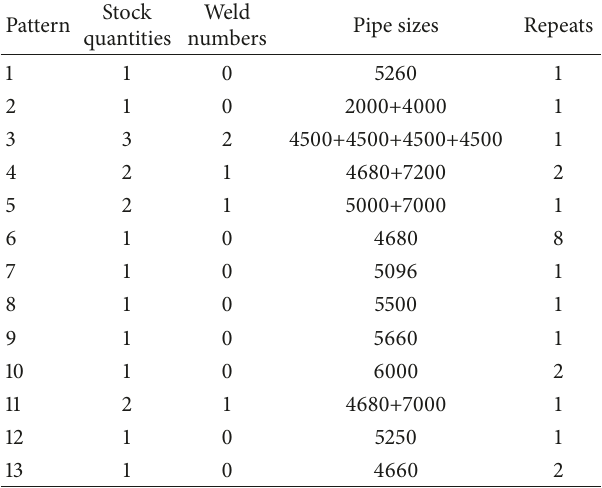
Table 4: Minimal cutting-and-welding patterns for 𝜋 𝑤 = 0.49𝜋 1